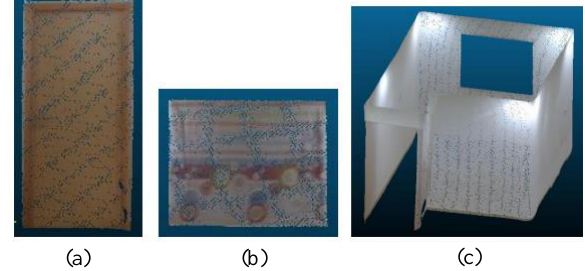
Figure 23. Room case: Segmentation of (a) door, (b) window, (c) wall without openings.